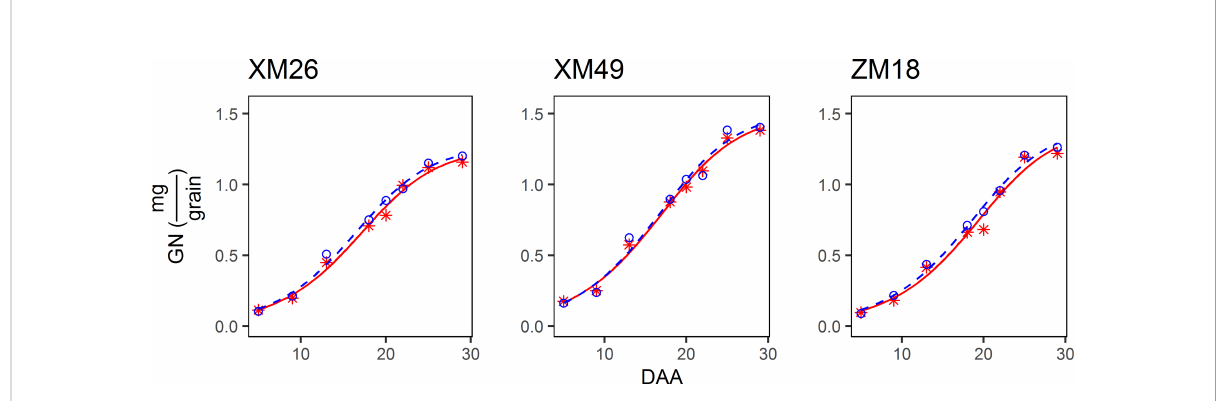
FIGURE 6 Dynamics of grain nitrogen content (GN) of different winter wheat genotypes under different irrigation levels. Red lines indicate high-water treatment, blue lines indicate low-water treatment, red stars represent high-water treatment observations, and blue circles represent low-water treatment observations. DAA, days after anthesis; XM26, Xinmai-26; XM49, Xinmai-49; ZM18, Zhoumai-18.